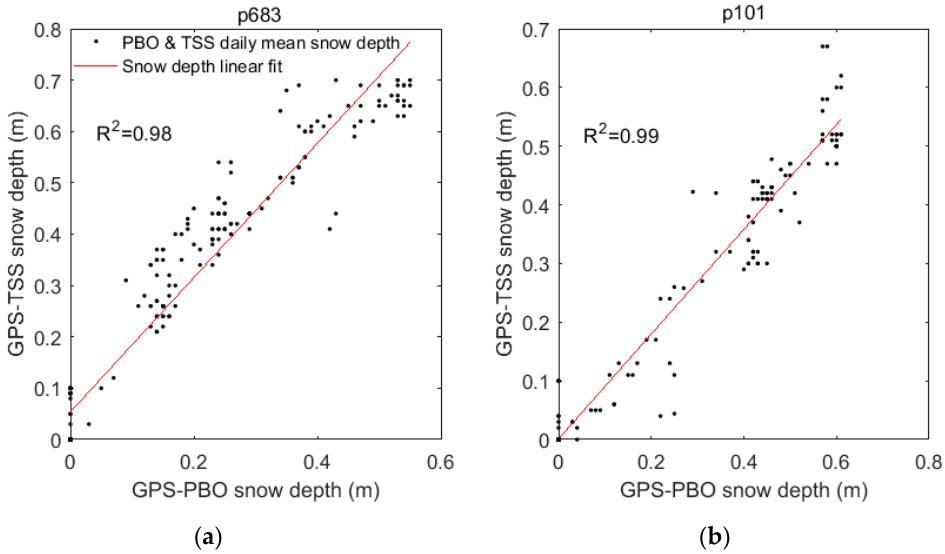
Figure 10. Comparison of snow depth estimations derived with GPS-PBO and GPS-TSS at p683 ( a ) and p101 ( b ). Black dots and red lines represent the daily mean snow depth derived from the GPS-PBO method and GPS-TSS method, and snow depth linear fit, respectively.